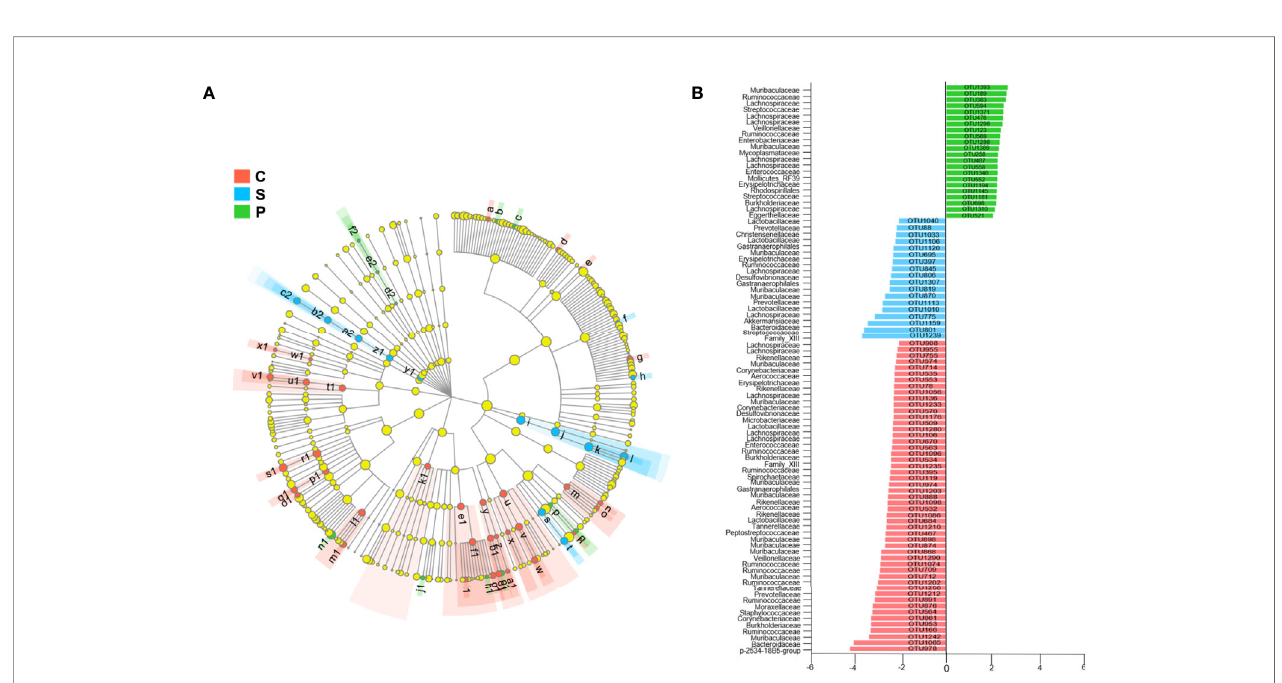
FIGURE 4 | Linear discriminant analysis effect size (LEfSe) analysis (LDA > 2.0). Cladogram (A) and histogram (B) illustrated 91 OTUs responsible for discriminating the PSD, stroke and control groups. Compared to stroke and control groups, the PSD rats were characterized by 22 discriminative OTUs (n = 6 per